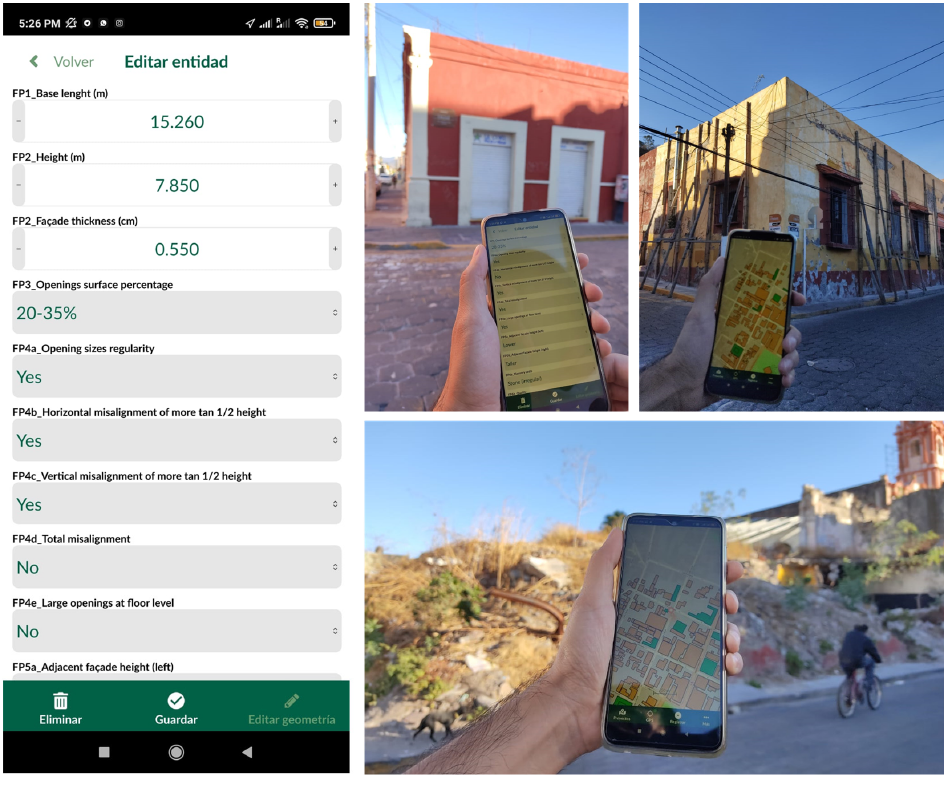
Figure 4. Example of the input interface and its utilisation during on-site data acquisition in the historical city of Atlixco (Puebla, Mexico) [29].